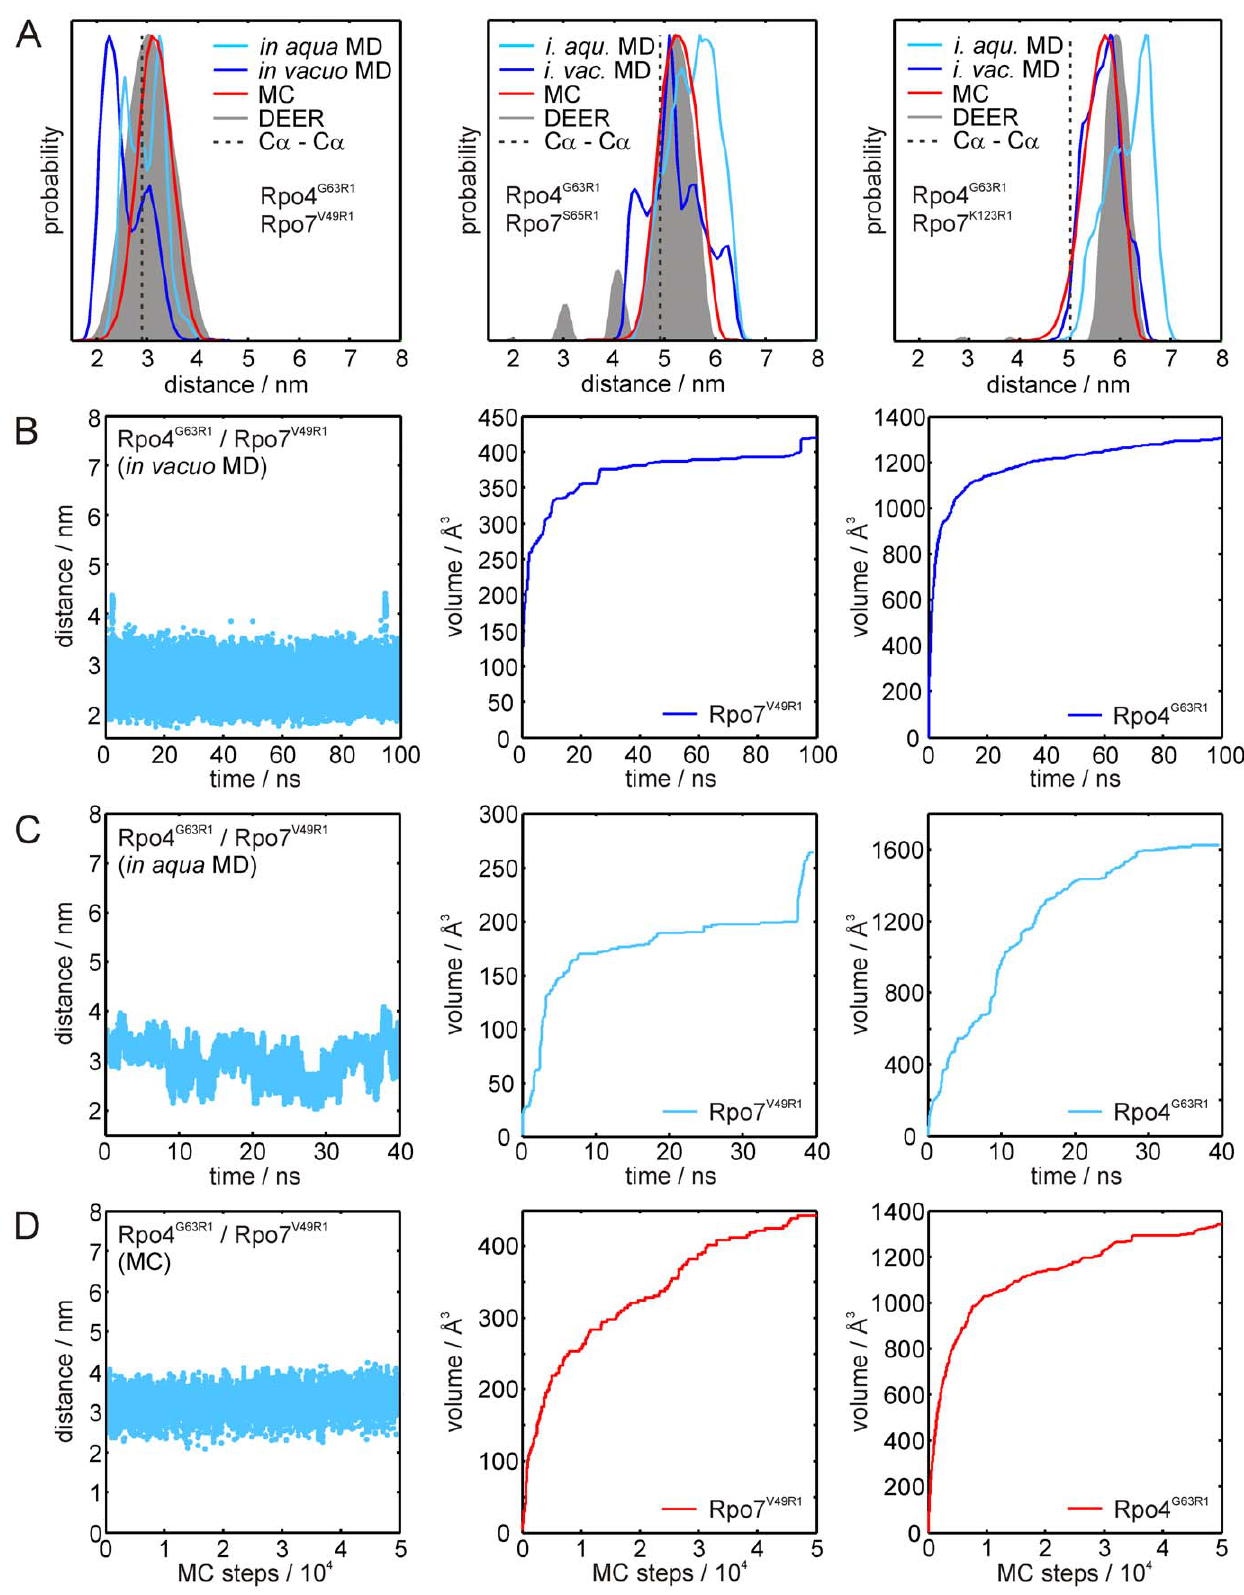
Figure 5. Results of the simulations for spin label pairs Rpo4 G63R1 /Rpo7 xR1 . (A) Distance distributions for the spin label pairs Rpo4 G63R1 / Rpo7 V49R1 (left), Rpo4 G63R1 /Rpo7 S65R1 (center) and Rpo4 G63R1 /Rpo7 K123R1 (right). Distance distributions obtained from the DEER experiments are shown in gray, the results of the in vacuo MD, in aqua MD and MC simulation are shown in dark blue, cyan and red, respectively. C a -C a distances